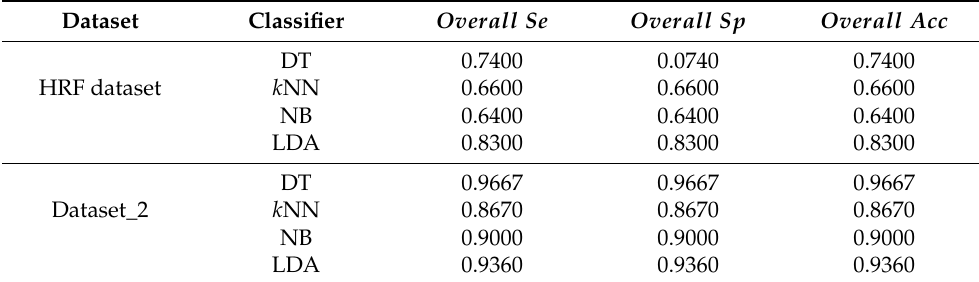
Table 7. Overall classification performance for the two